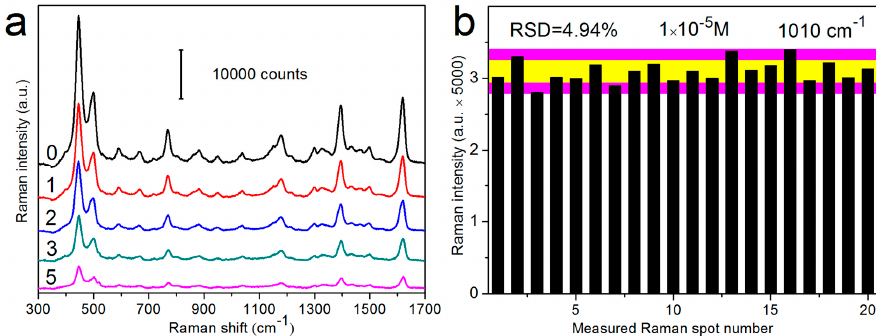
Figure 2. ( a ) Raman spectra of 5 × 10 − 6 M methylene blue (MB) molecules adsorbed on the uncoated AgNRs substrate (0 cycle) and on AgNR arrays coated with Al 2 O 3 layers by 1, 2, 3, and 5 ALD cycles (Reprinted with permission from [49]); ( b ) SERS intensity distribution of 1 × 10 − 5 M dipicolinic acid (DPA) at 1010 cm − 1 band from 20 randomly selected spots over the AgNRs substrate coated with an Al 2 O 3 layer by 1 ALD cycle (Reprinted with permission from [56]. Copyright (2015) American